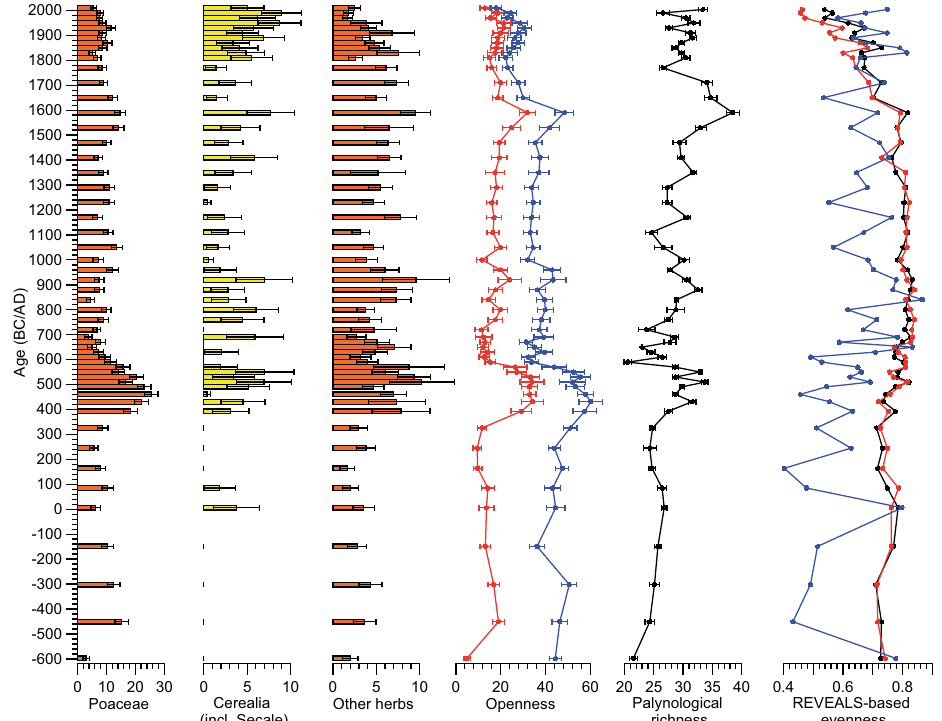
Fig. 4. Regional vegetation cover for selected taxa/taxa groups, openness, palynological richness and REVEALS-based evenness between 600BC to AD2008. Openness was estimated both including and excluding shrubs ( Juniperus and Corylus ) shown by blue and red lines, respectively. REVEALS-based evenness was calculated for all 26 reconstructed taxa (black line), but also for trees (red line) and herbs (blue line)